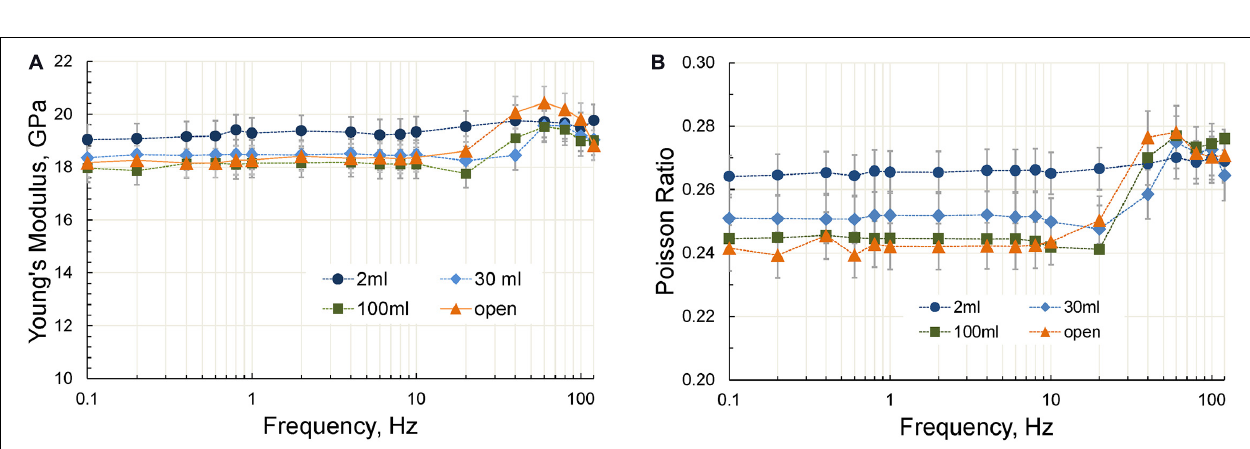
FIGURE 10 | The frequency dependences of the Young’s modulus (A) and Poisson ratio (B) measured at dead volumes of 2, 30, and 100 ml, as well as with the open fluid line. All measurements are performed at a differential pressure of 7 MPa.